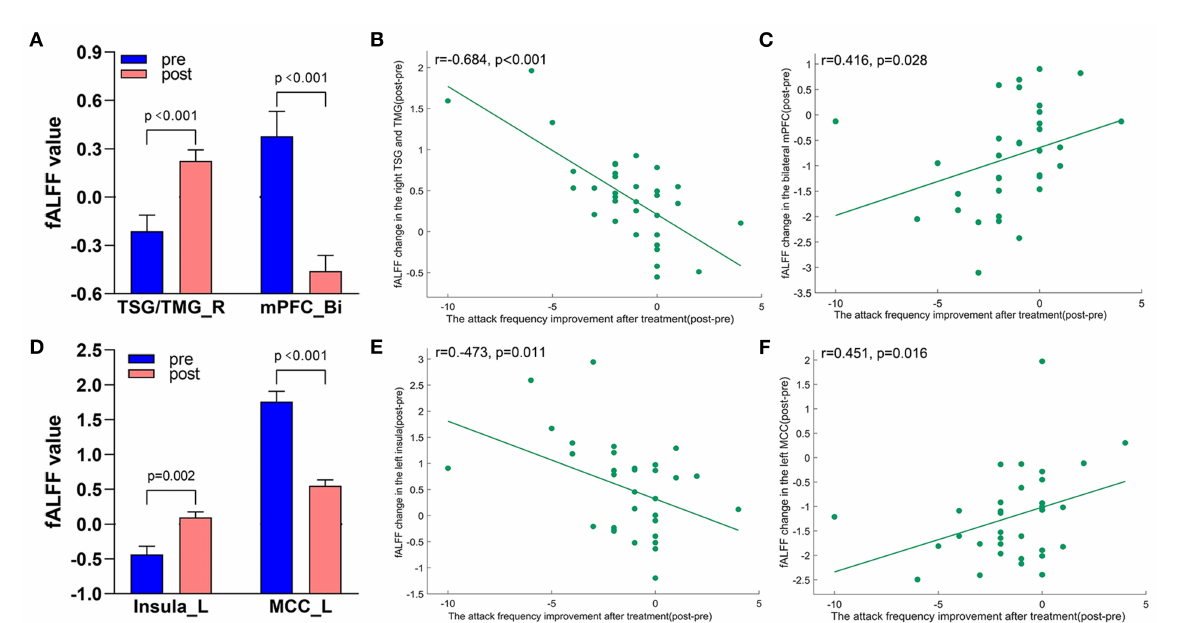
FIGURE7 Treatment response of fALFF (mean ± sem) and correlation between fALFF changes and migraine frequency changes (FDR corrected). (A) Significant decrease and increase of fALFF in bilateral mPFC and right TSG/TMG after tVNS treatment. (B) A negative correlation between right TSG/TMG and the reduction of migraine attack frequency (r = − 0.684, p < 0.001). (C) A positive correlation between bilateral mPFC and the reduction of migraine attack frequency (r = 0.416, p = 0.028). (D) Significant increase and decrease of fALFF in the left insula and left MCC after tVNS treatment. (E) A negative correlation between left Insula and the reduction of migraine attack frequency (r = − 0.473, 0.011). (F) A positive correlation between left MCC and the reduction of migraine attack frequency (r = 0.451, p = 0.016). Bi, bilateral; L, left; MCC, middle cingulate cortex; mPFC, medial prefrontal gyrus; R, right; TMG, middle temporal gyrus; TSG, superior temporal